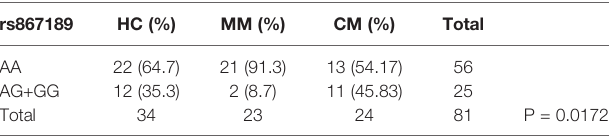
TABLE 2 | Clinical characteristics in different genotypes of rs867186 of the PROCR gene (EPCR).